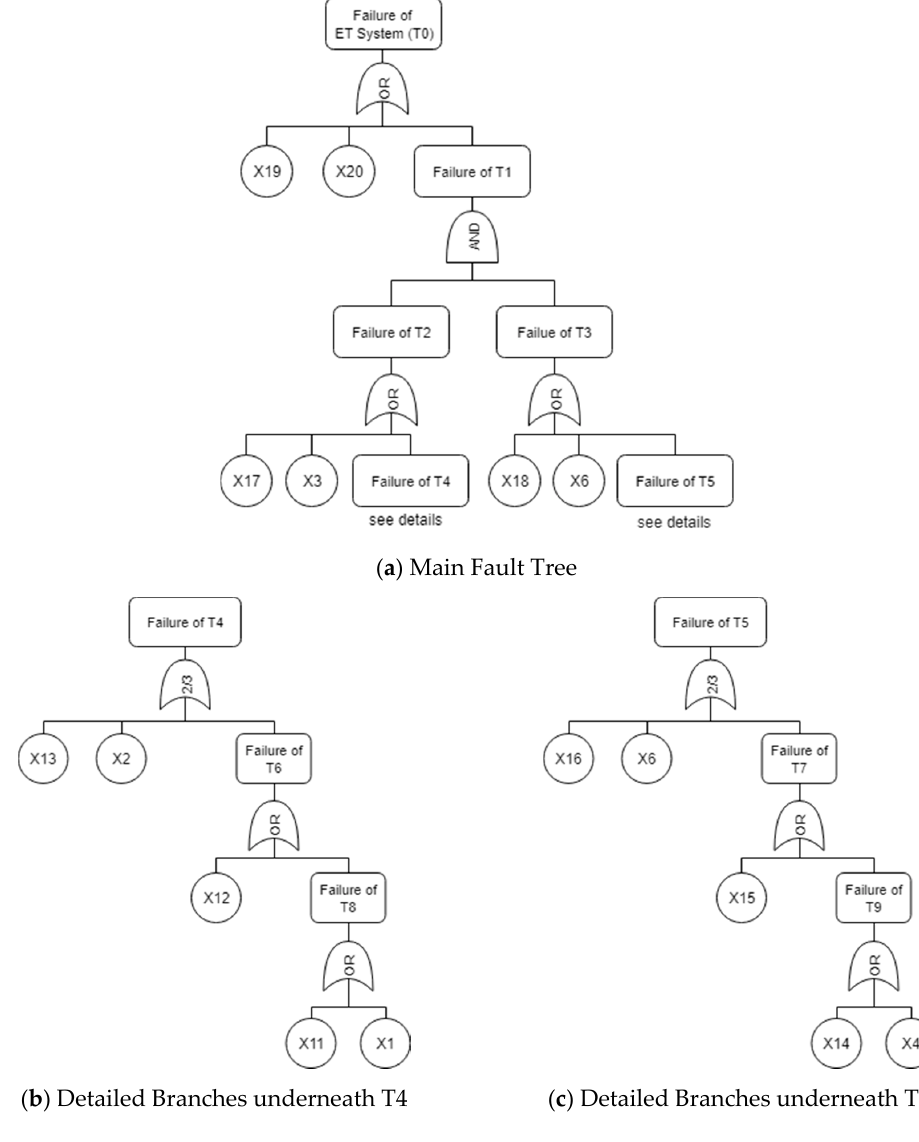
Figure 6. Fault tree (FT) of energy transfer system.